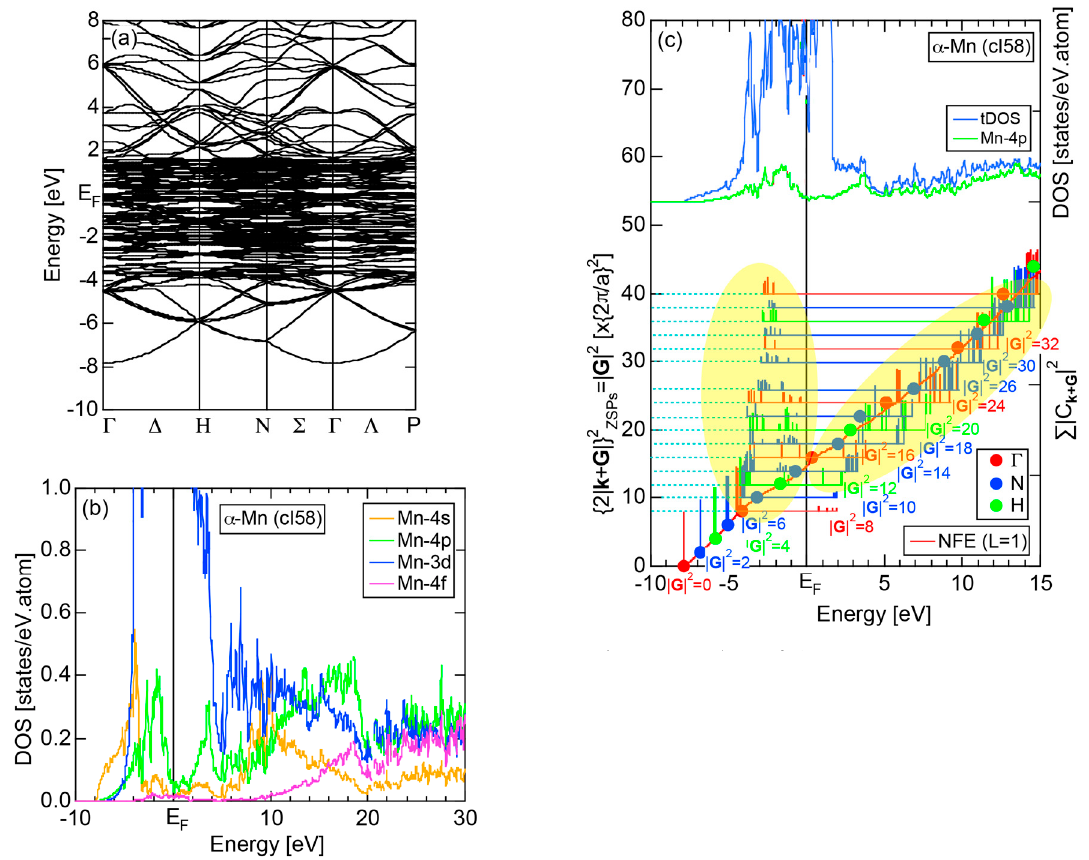
Figure 16. ( a ) Dispersion relations; ( b ) Mn-partial DOSs and ( c ) FLAPW-Fourier spectra at symmetry points Γ , N and H of the bcc Brillouin zone for α -Mn (cI58) [11]. The total-DOS (blue) and Mn-4p partial DOS (green) are incorporated in ( c ). Formation of bonding and anti-bonding states due to the Mn-3d-states-mediated splitting is highlighted by yellow color in ( c